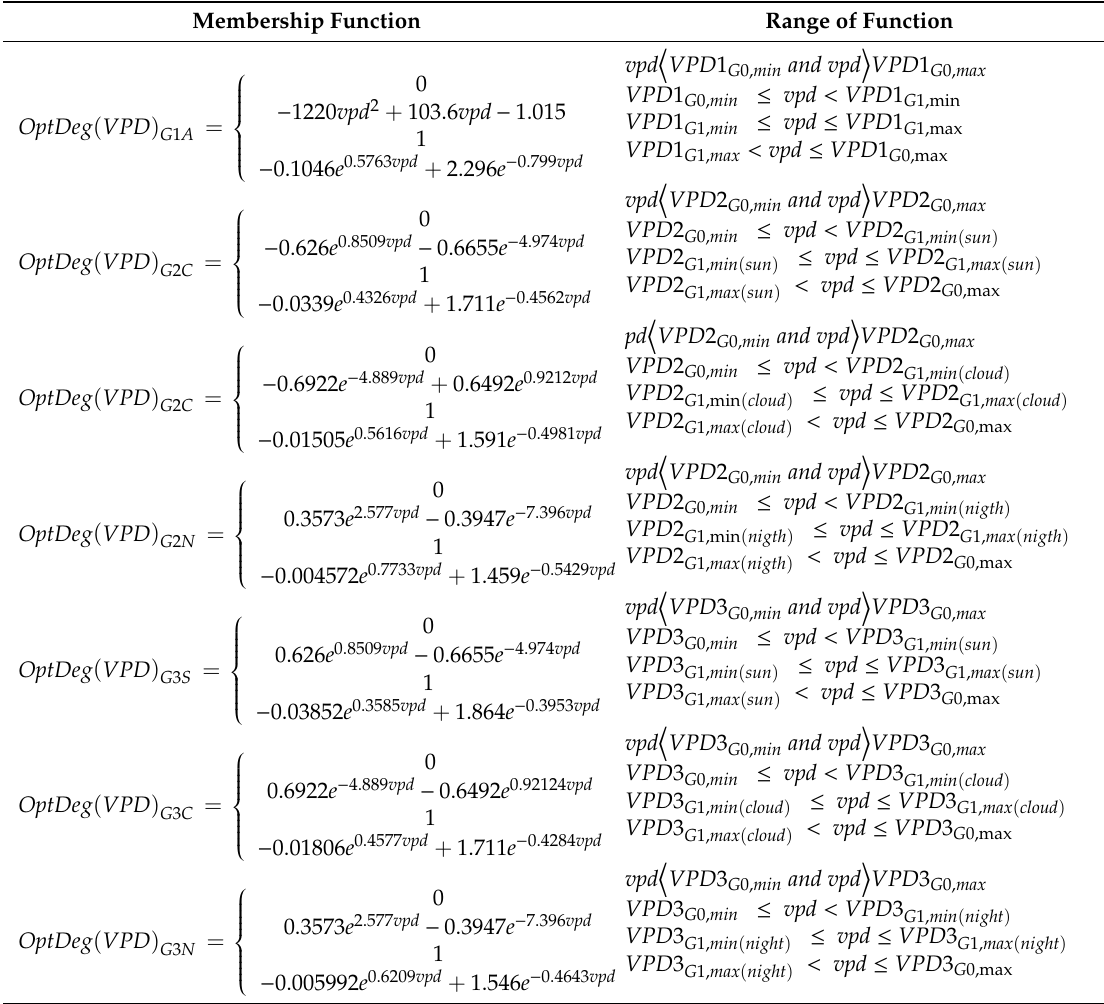
Table 3. Mathematical descriptions of the membership functions defining optimality degrees of vapor pressure deficit [16,29,31]. G1: G0: index of failure, Growth stage1, G2: Growth stage2, G3: Growth stage3, A: All light conditions, N: Night, C: Cloud, S: